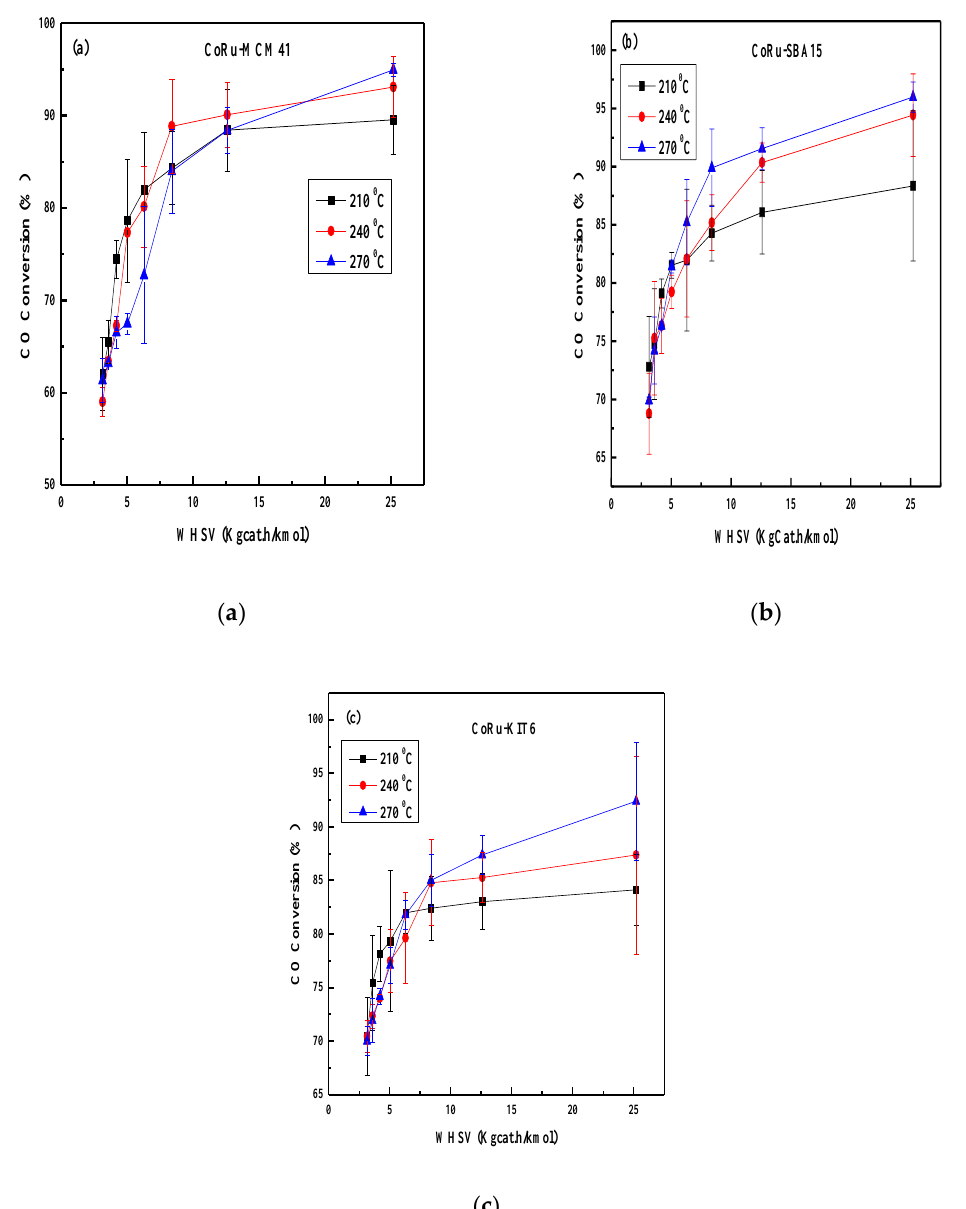
Figure 7. Effect of space velocity on CO conversion: ( a ) CoRu-MCM-41; ( b ) CoRu-SBA-15; ( c ) CoRu-KIT-6.